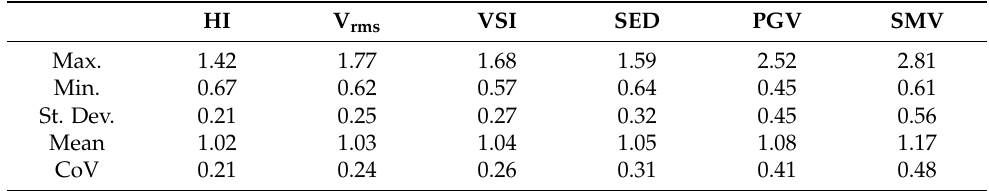
Table 9. Statistical values of the velocity related 5 parameters normalized with analyses